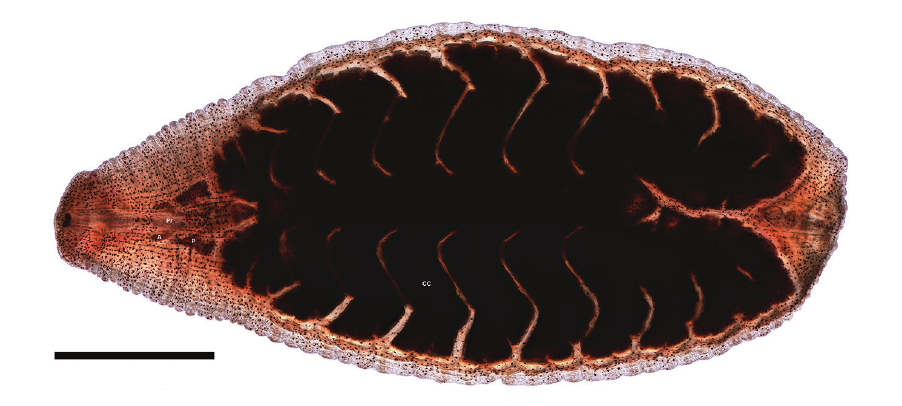
Figure 3. Paratype specimen of Placobdella siddalli Richardson & Moser, YPM IZ 083876 mounted in Canada balsam, crop ceca ( CC ), anterior salivary gland ( A ), posterior salivary gland ( P ), proboscis ( Pr ). Scale bar: 2